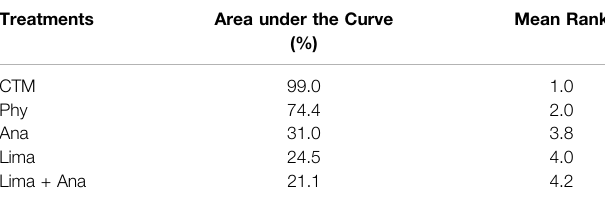
TABLE 3 | Area under the curve and the mean rank for VAS. Treatments